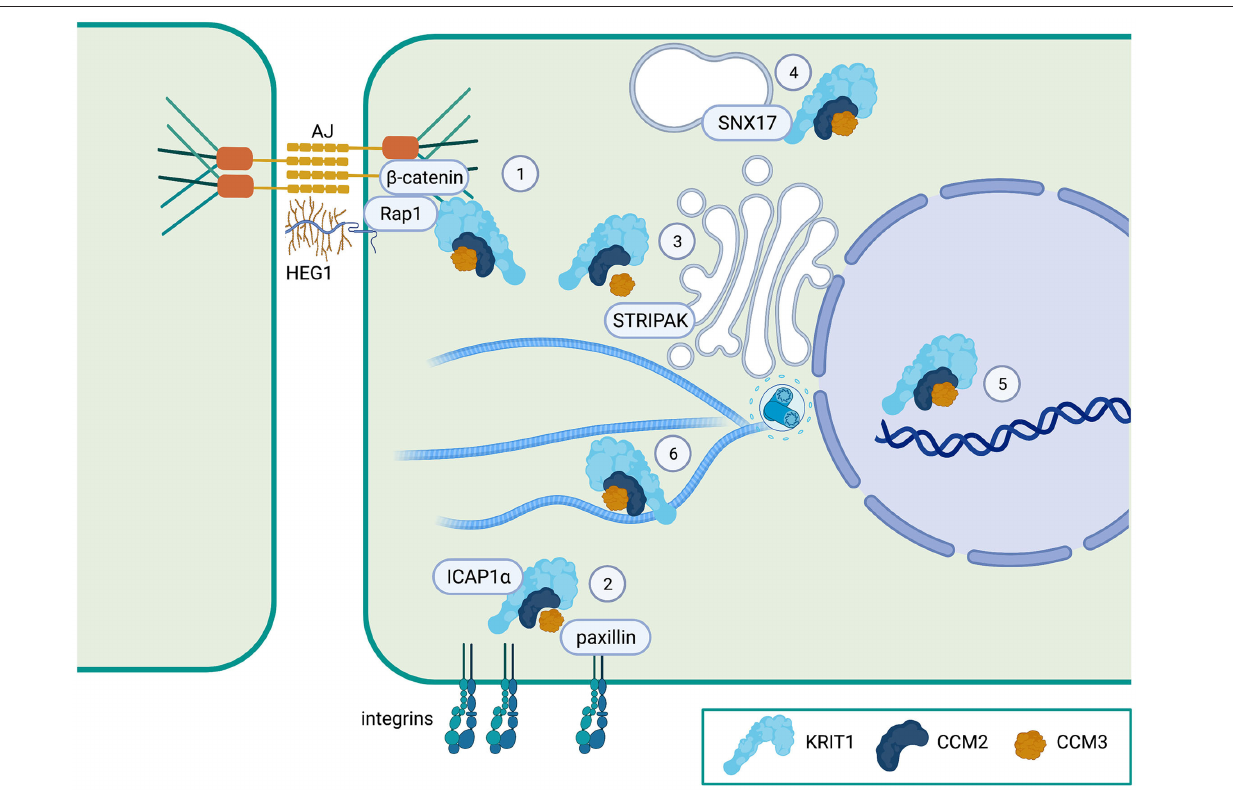
FIGURE 2 | Proposed localization of the CCM complex. (1) The CCM complex is known to co-localize with β -catenin at adherens junctions (AJ) and to associate with the Heart of Glass (HEG1) orphan transmembrane receptor at the plasma membrane. (2) The CCM complex (at least KRIT1), regulates ICAP1 α interactions with integrins. CCM3 can also bind to paxillin, a focal adhesion protein. (3) CCM3 is a member of the STRIPAK signaling complex which regulates cell polarity and Golgi assembly. (4) KRIT1 can bind to the endosomal trafficking protein sorting nexin-17 (SNX17). (5) All three CCM proteins can localize to the nucleus, but whether they have a nuclear function is unknown. (6) The CCM complex is also distributed in the cytoplasm, where KRIT1 can bind to microtubules. Created with Biorender.com.